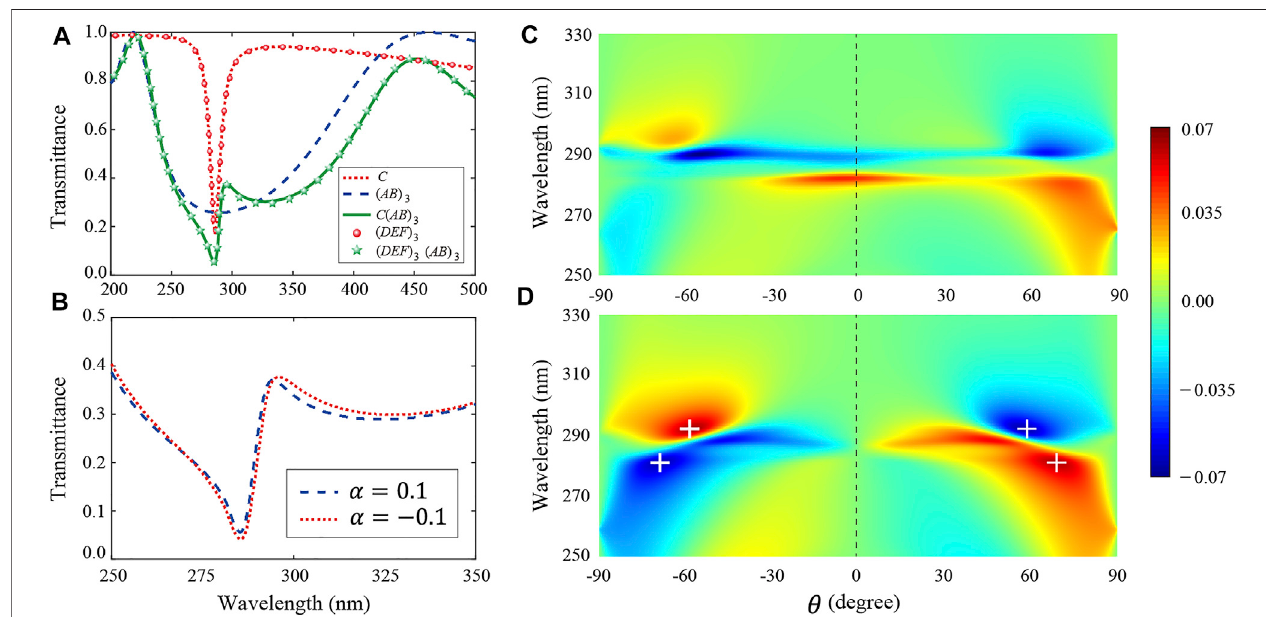
FIGURE7|(A) TransmittancespectrumofClayerbasedontheeffectiveparametersfrom( DEF ) m ,the1DPC:( AB ) 3 ,thecompositestructure: C ( AB ) 3 ,themultilayer structure: ( DEF ) 3 , and the composite structure: ( DEF ) 3 ( AB ) 3 , which corresponds to the dotted red line, dashed blue line, solid green line, red dotted line, and green star line, respectively. The incident angle is θ = 50 ° . (B) The transmittance spectrum of the composite structure ( DEF ) 3 ( AB ) 3 for different external magnetic fi eld: α = 0.1 (dashed blue line) and α = -0.1 (dotted red line), respectively. (C) The dependence of Δ T 1 (cid:1) T | α (cid:1) 0 . 1 − T | α (cid:1) 0 on the incident angle θ and wavelength when a TM- polarized plane wave is incident on the composite structure ( DEF ) 3 ( AB ) 3 . The dashed line denotes the position of θ = 0 ° . (D) Similar to (C) , but for the case of Δ T